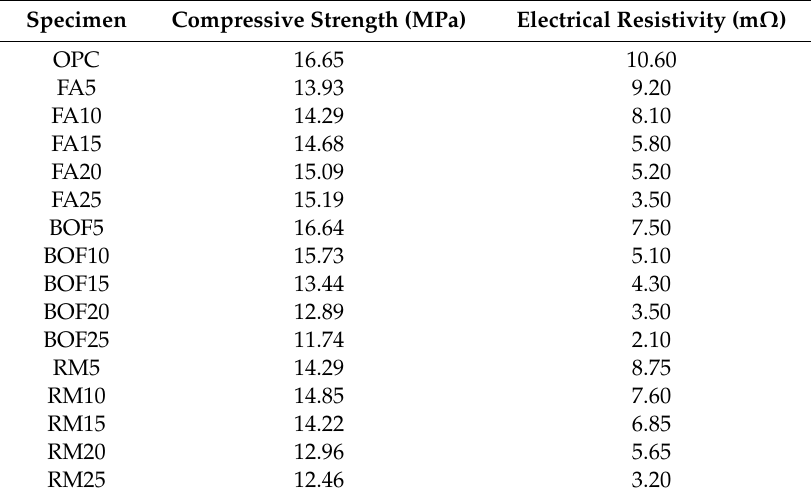
Table A1. Compressive strength and electrical resistance results for the environment-friendly, self-sensing concrete cured at the age of 3